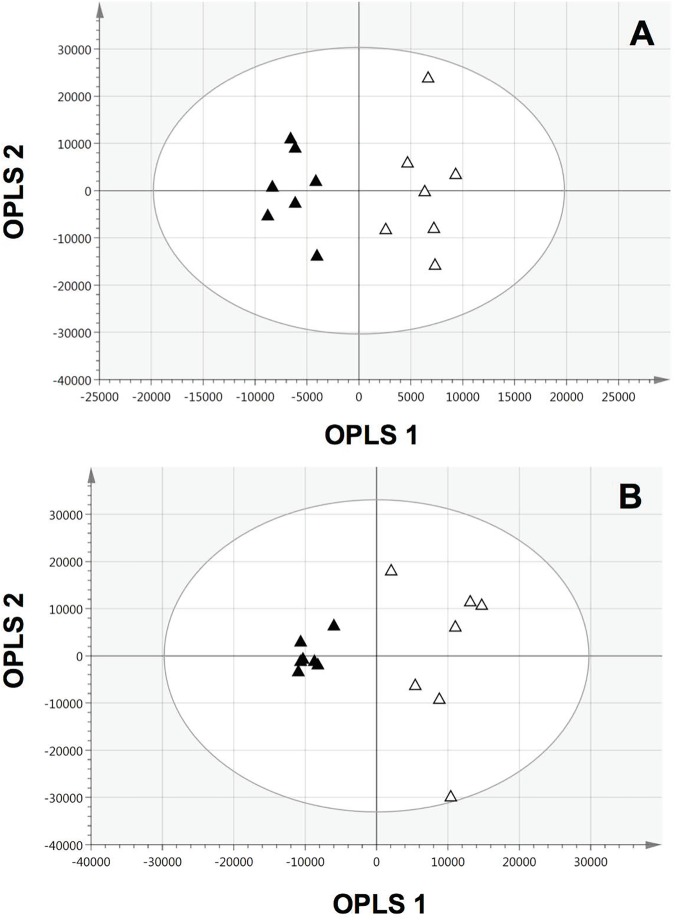
OPLS-DA score plots from plasma metabolic profiles of moderately insulin sensitive and insulin resistant veal calves.The white triangles represent moderately insulin sensitive veal calves (n = 7) and black triangles represent insulin resistant veal calves (n = 7). The models were obtained using C18 LC-MS (A) and HILIC LC-MS (B) blood plasma metabolic profiling. R2Y, which is the variation described by the models was 92 and 90% for the C18 and HILIC model, respectively. Q2Y, which describes how accurately the models can predict class membership, was 66 and 73% for the C18 and HILIC model, respectively.